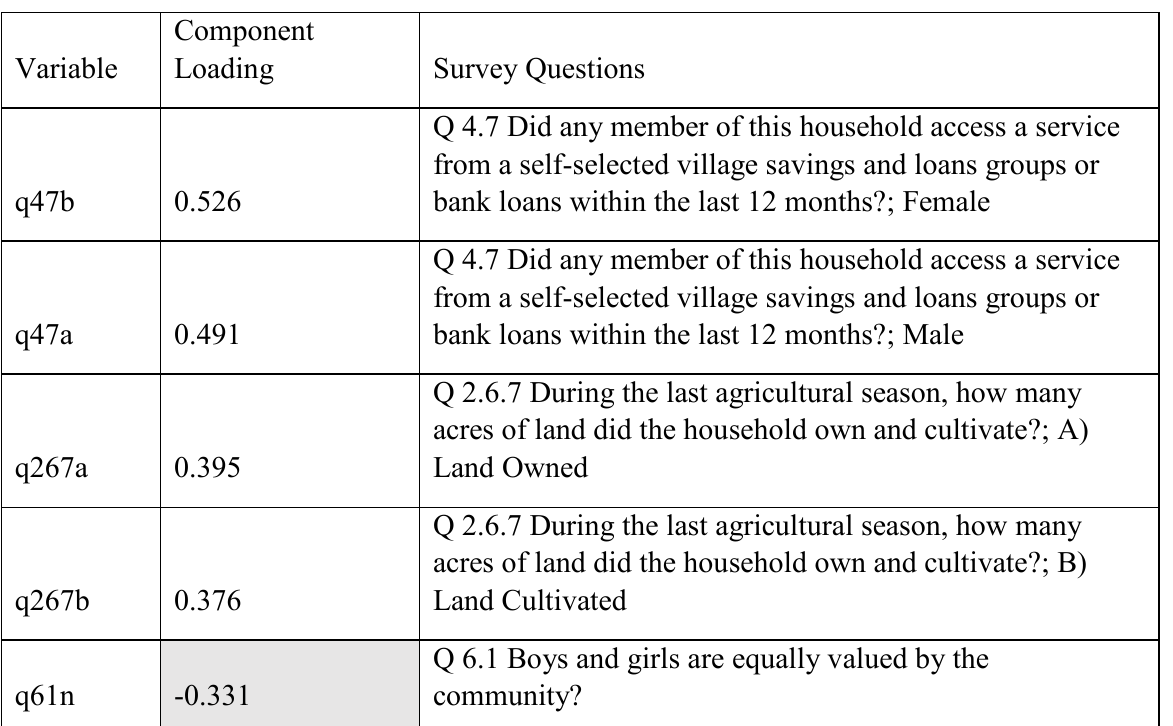
Table 1.50: Variables defining Transformative Resilience